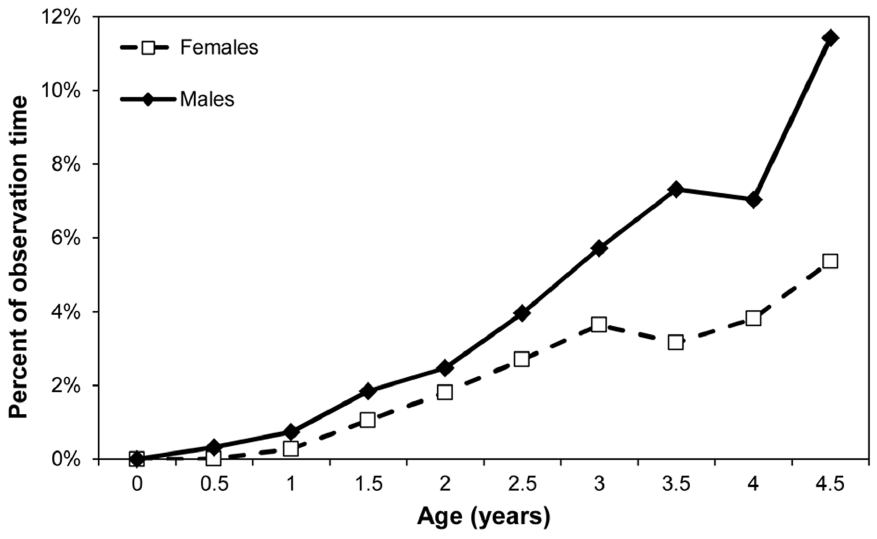
Figure 5. Mean percent of observation time spent traveling independently for male and female infants.